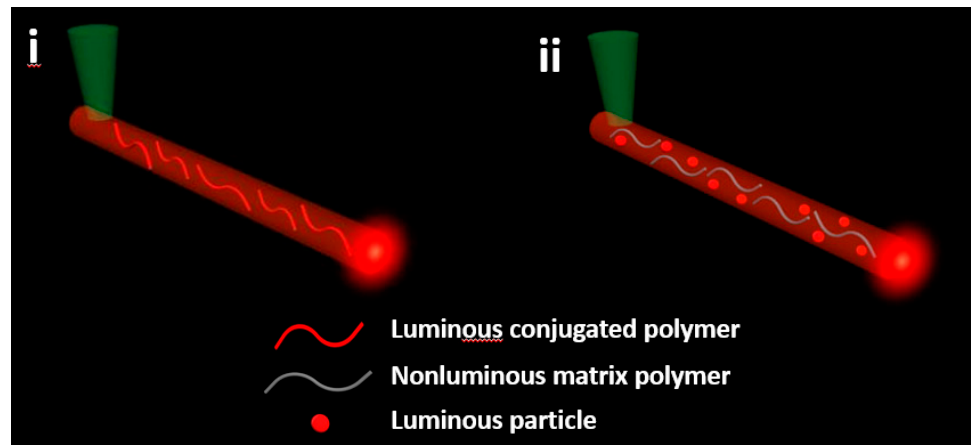
Figure 1. Structure of luminescent polymer micro/nanofibers: (i) the micro/nanofiber is made of self-luminous conjugated polymers; (ii) the micro/nanofiber is composed of nonluminous matrix polymers and doped luminescent dyes (organic and inorganic luminescent particles).